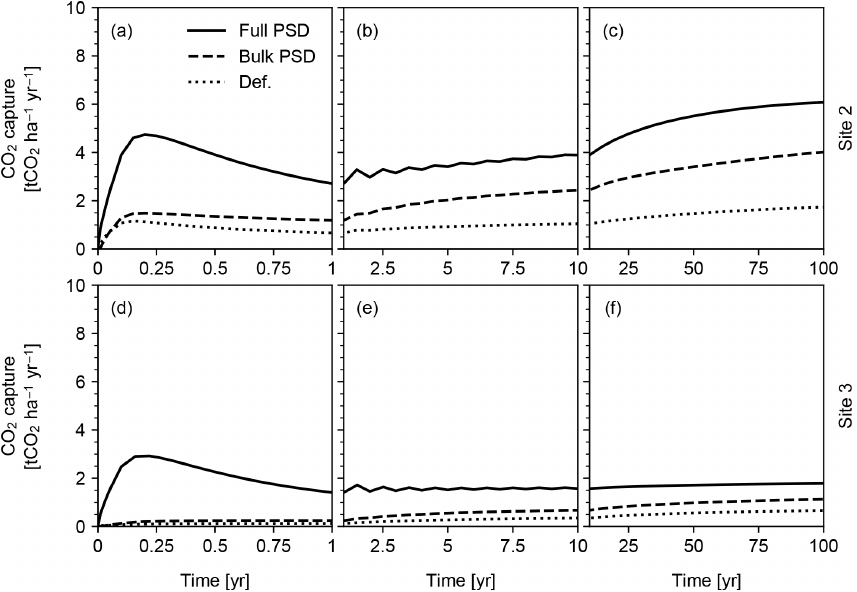
Figure 15. CO 2 capture predicted in simulations of pulsative basalt application at Sites 2 and 3 in Table 8. Milled basalt (dominated by 5, 20, 50 and 70µm particles) is applied non-continuously and homogeneously mixed at the soil surface. See Sect. 3.2.2 for